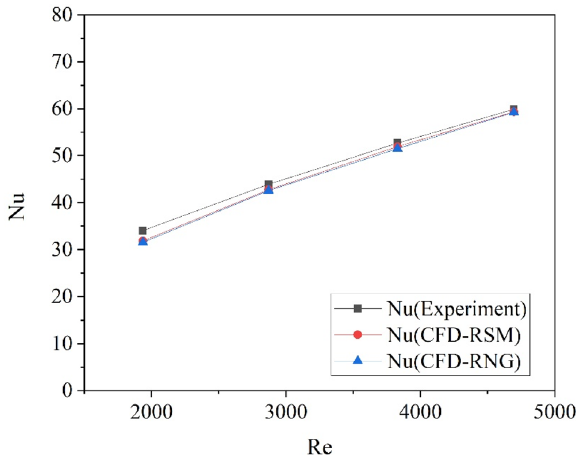
Figure 3. Comparison for the calculated Nusselt numbers of twisted tape with experimental data.